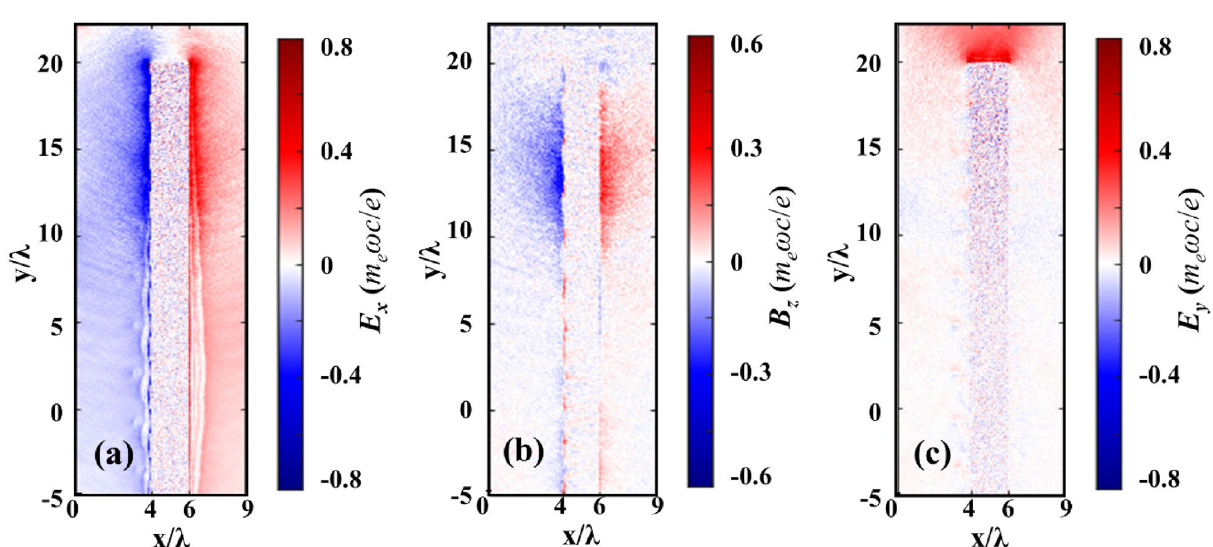
Figure 8. Quasi-static electromagnetic fields ( a ) E x , ( b ) B z , and ( c ) E y at t = 60 T 0 for Gr500. The electric and magnetic fields are normalized by